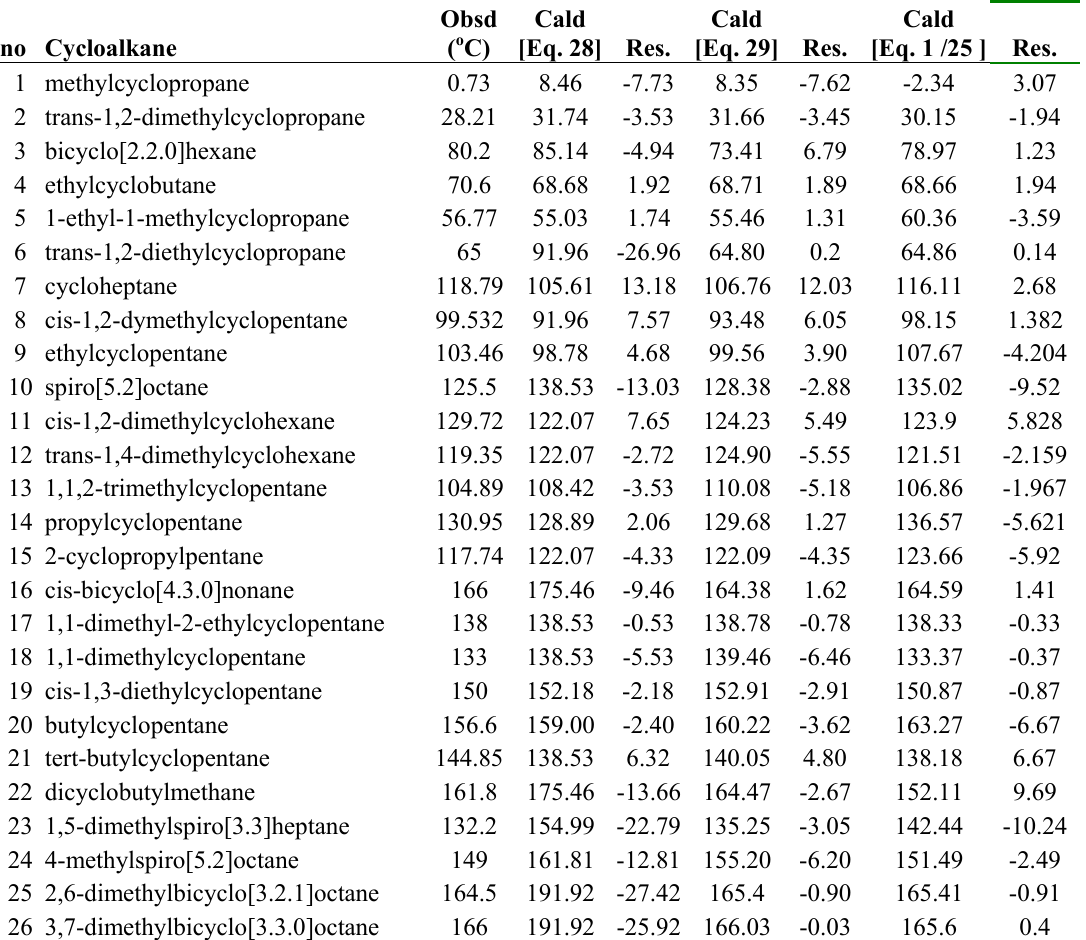
Table 13 . Experimental and Calculated Bp of Cycloalkanes of the Test